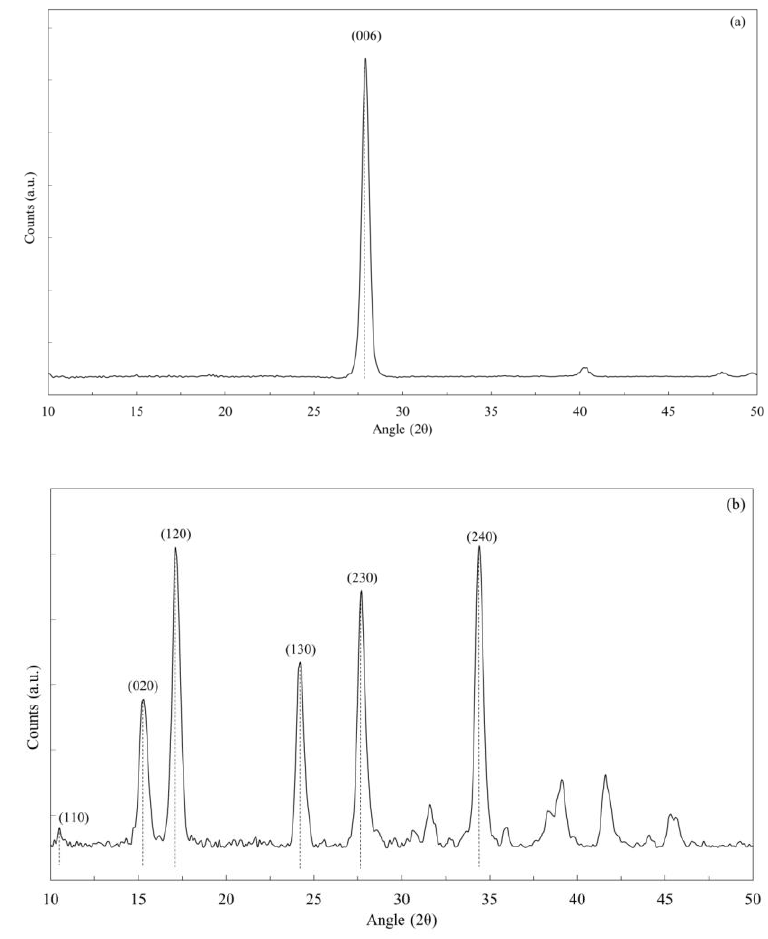
Figure 2. X-ray diffraction (XRD) spectrum of ( a ) InSe ( b ) Sb 2 Se 3 .